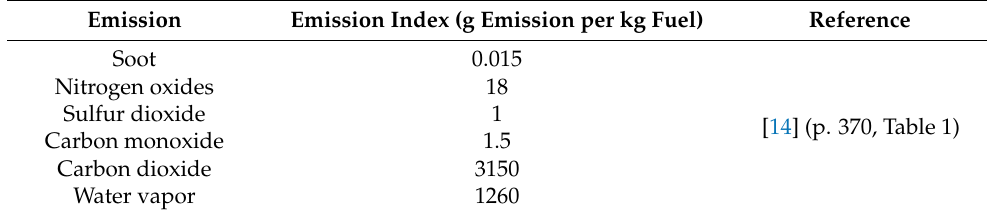
Table 1. Typical emissions per kg fuel for air transport.